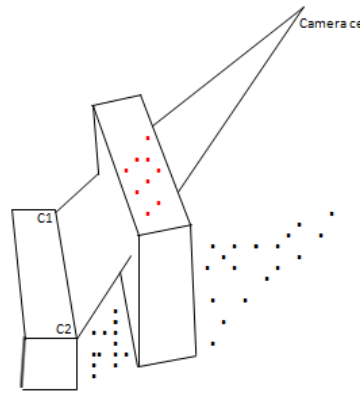
Figure 3: Occlusion from other building. Red dots represents laser points above the plane formed by wall corners and camera center. Black dots are other laser